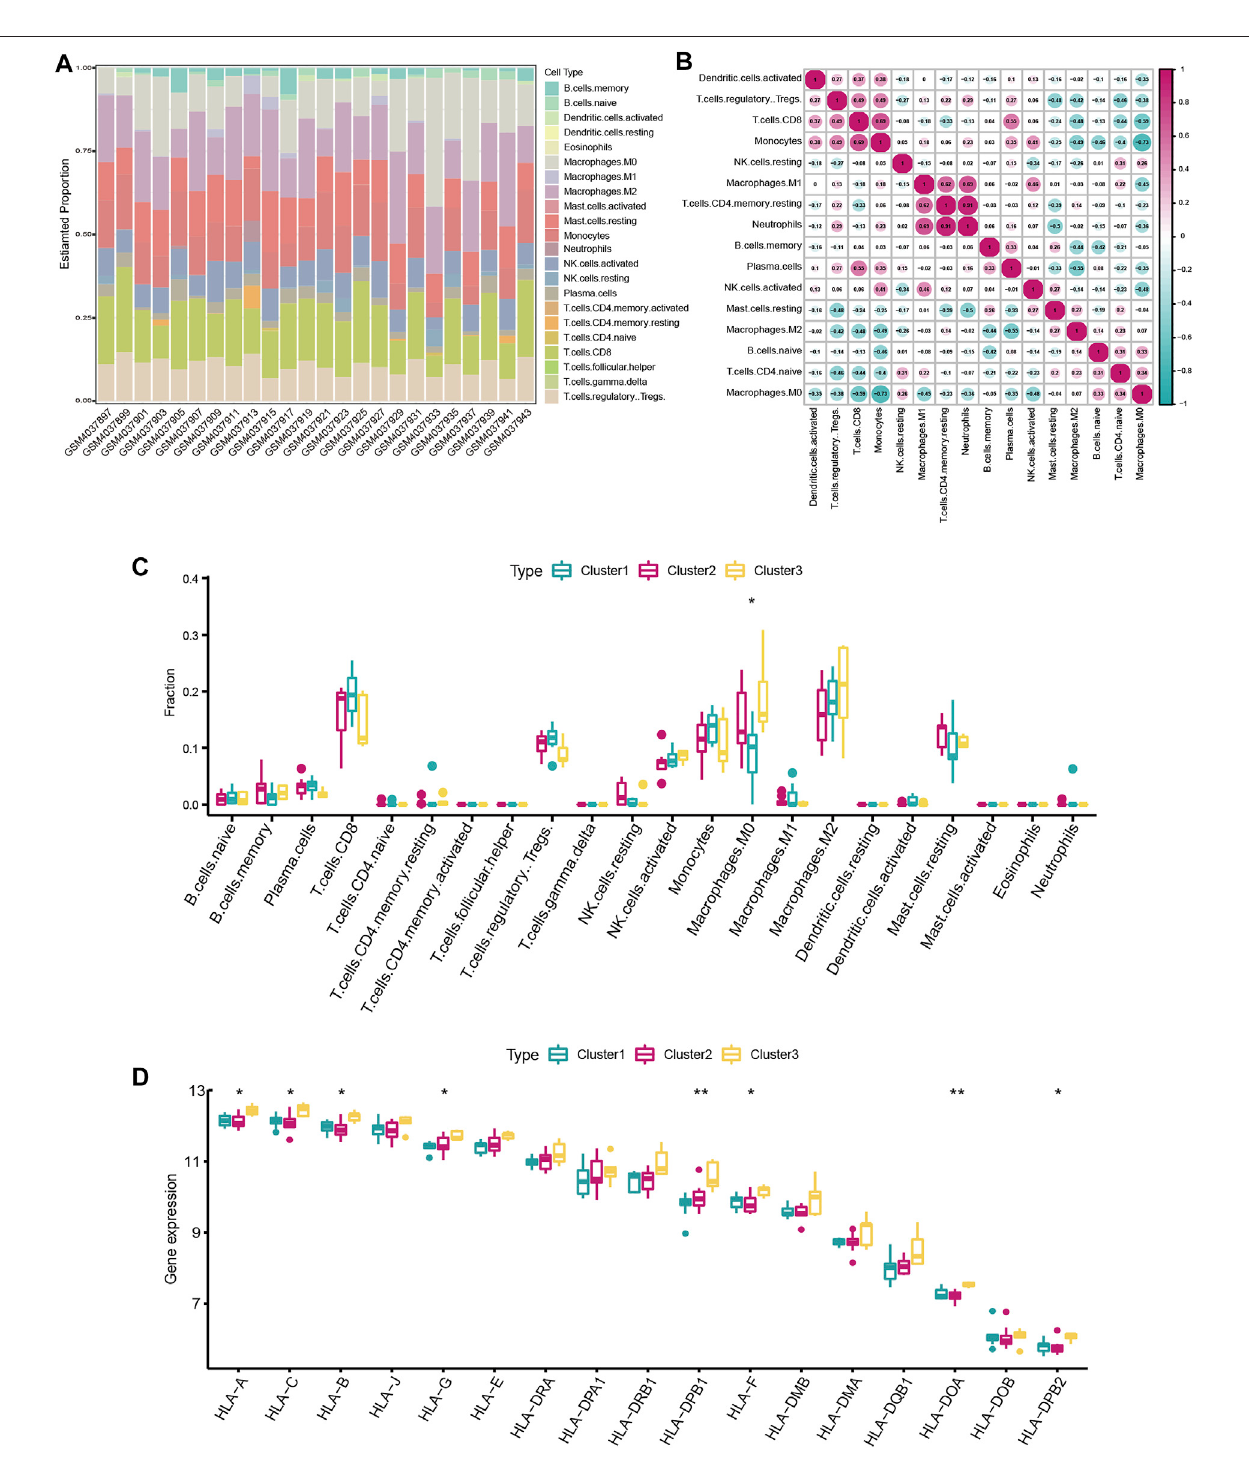
FIGURE 5 | Immune microenvironment characteristics among distinct severe OSA subtypes. (A) Relative proportions of immune cell in fi ltration in severe OSA individuals. (B) Correlation matrix of the 22 immune cell proportions. (C) Differences in immune cell in fi ltration abundances among three m6A modi fi cations. (D) The expression differences of each HLA gene in three m6A modi fi cation patterns.